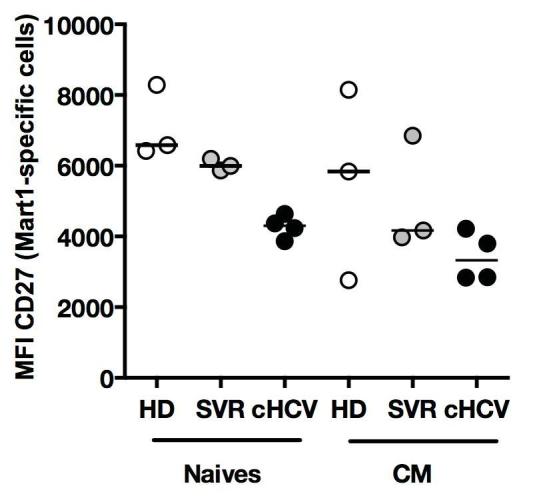
Phenotype of Ag-specific inexperienced T cells in cHCV patients.Percentages of naïve, CM, EM, and EMRA – phenotype Ag-specific Mart1-, Ebola-, and HIVspecific T cells enriched from chronic HCV patients.